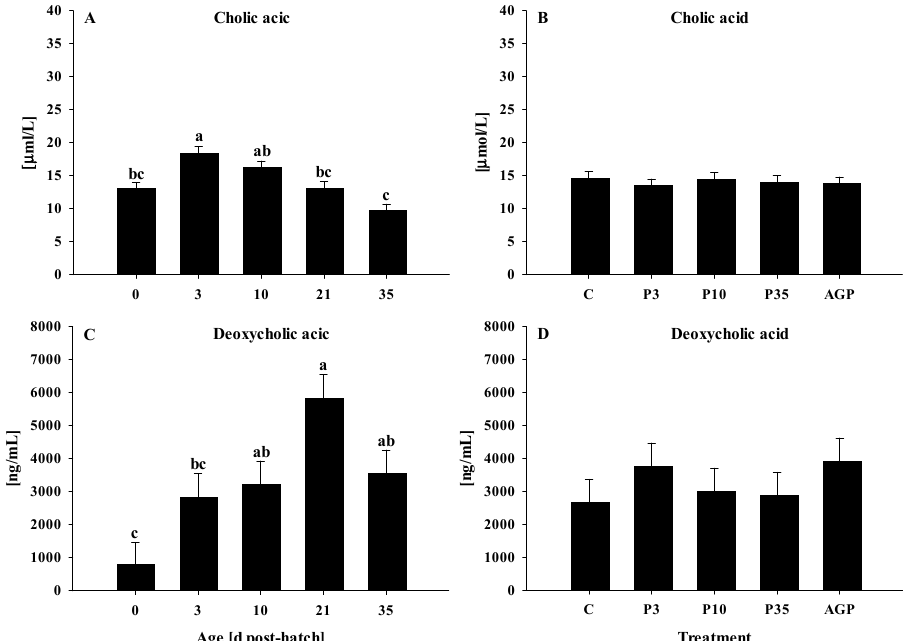
Figure 5. Age and treatment effects on plasma cholic acid and ileal deoxycholic acid. Age effects on ( A ) plasma cholic acid and ( C ) ileal deoxycholic acid. Treatment effects on ( B ) plasma cholic acid and ( D ) ileal deoxycholic acid. Each value represents mean ± SE. Treatments are C, normal water (without supplements) from day 0 to 35 post-hatch; P3, FM in water for first 3 days post-hatch followed by normal water until day 35; P10, FM in water for first 10 days post-hatch followed by normal water until day 35; P35, FM in water from hatch to day 35; and AGP, AGP in water from hatch to day 35. a,b,c Letters indicate significance ( p < 0.05) between days post-hatch.